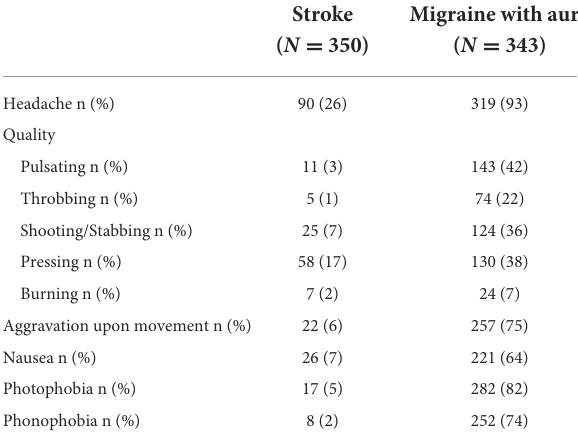
TABLE 3 Headache characteristics of patients with acute ischemic stroke and migraine with